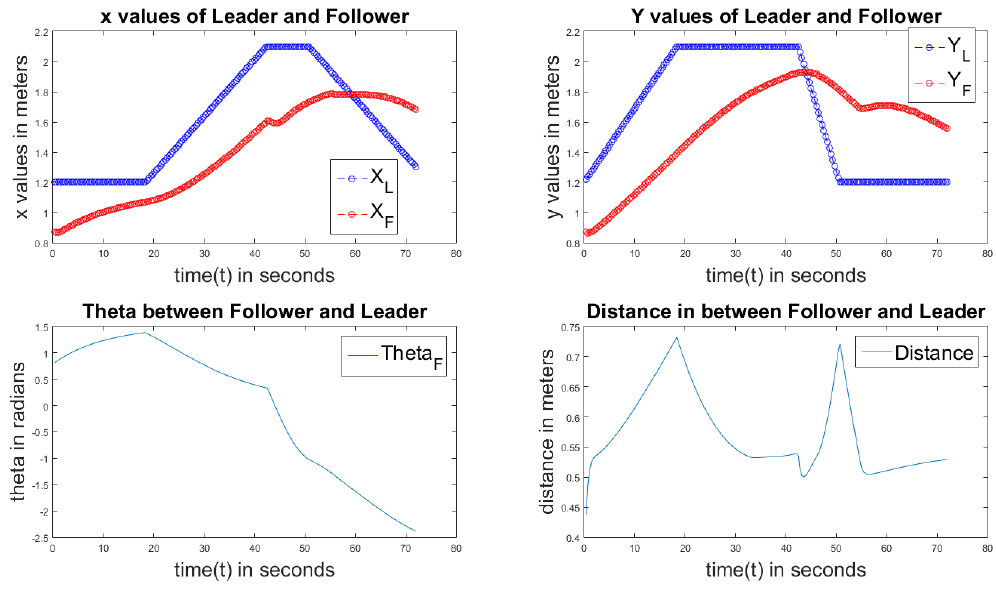
Figure 10. P controller of a square.